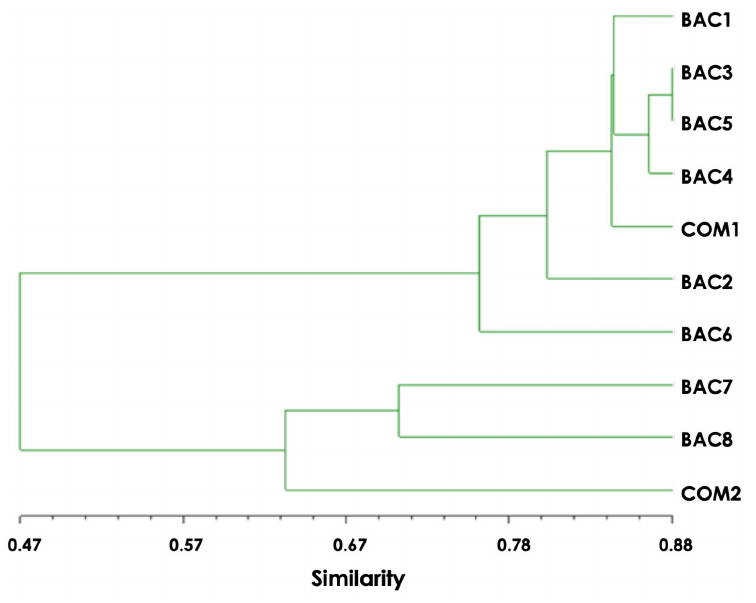
Figure 2. The dendrogram of Gymnema inodorum samples generated from the similarity matrix of RAPD data.